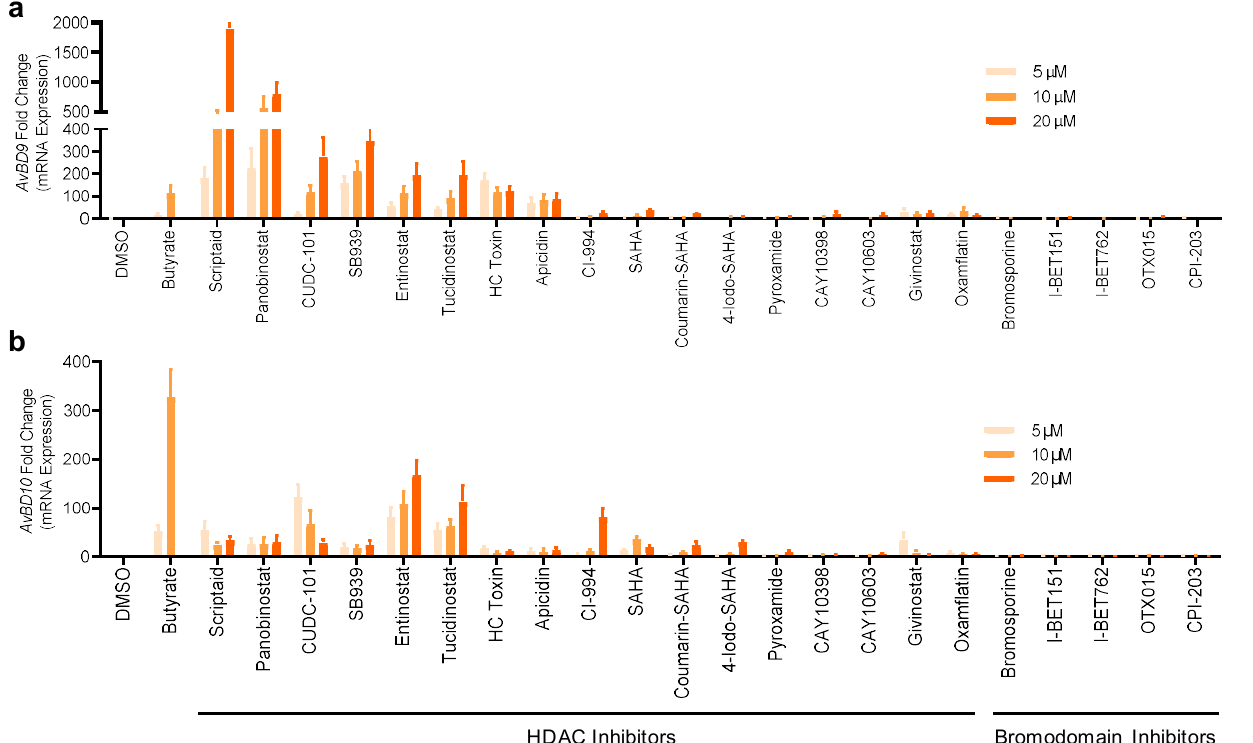
Figure 5 . Induction of the AvBD9 and AvBD10 mRNA expression by seven selected compounds in chicken HD11 macrophages. HD11 cells were stimulated in duplicate with indicated concentrations of each compound for 24 h, followed by RT-qPCR of AvBD9 ( a ) and AvBD10 ( b ) expression. Fold changes were calculated relative to DMSO-treated cells using the ΔΔCt method. The results are means ± SEM of 3–4 independent experiments. ** p < 0.01, *** p < 0.001, and **** p < 0.0001 relative to the DMSO control (by one-way ANOVA and post-hoc Dunnett’s multiple comparisons test).